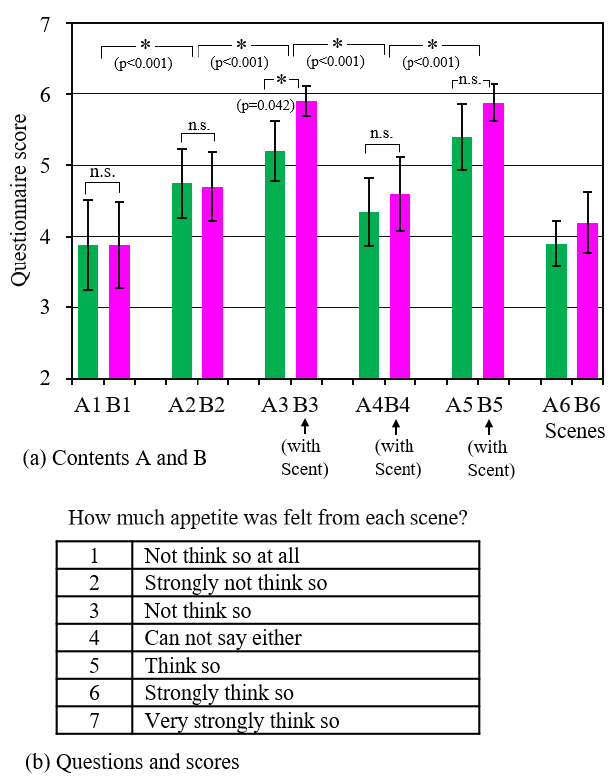
Figure 5. Questionnaire results for each scene.